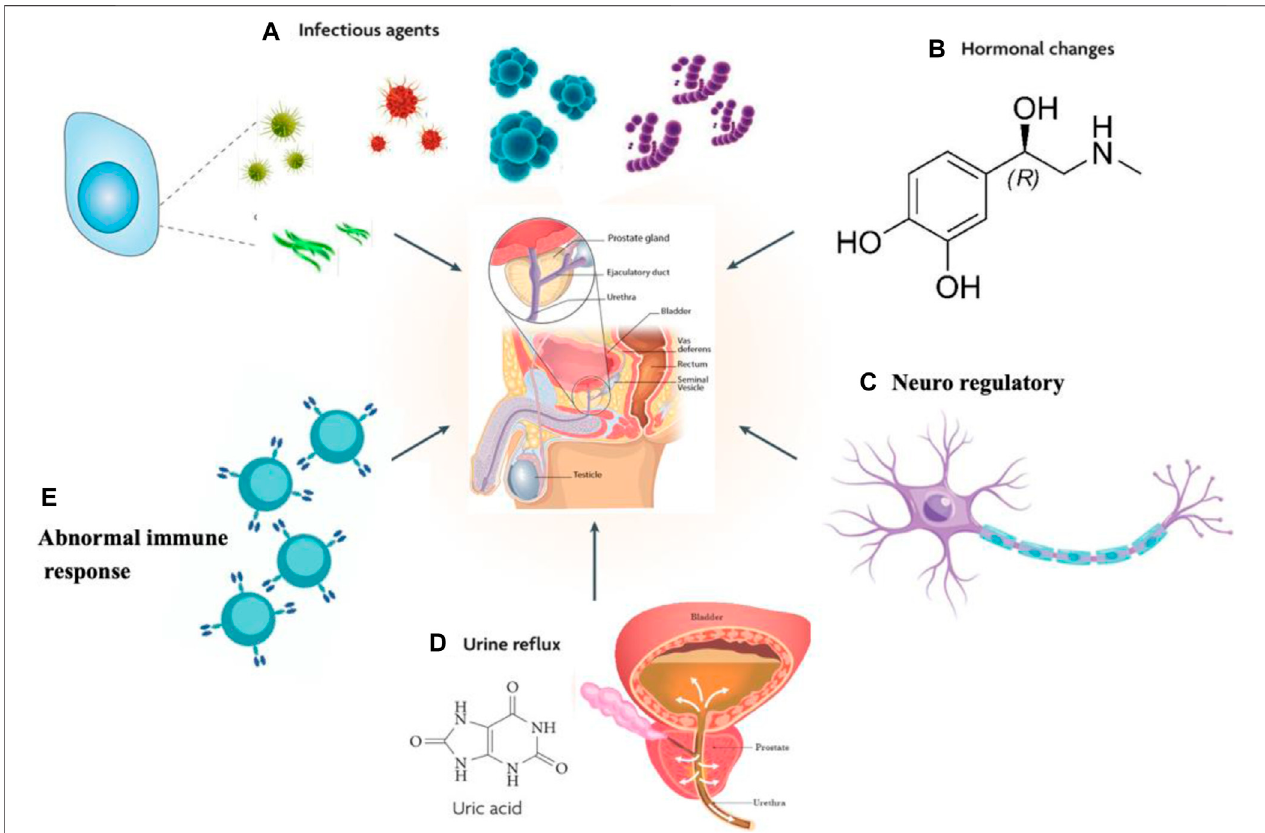
FIGURE 1 | Possible causes of prostate in fl ammation. ( A ) Pathogen infection. ( B ) Sex hormone imbalance. ( C ) Urination dysfunction. ( D ) Neuroregulatory mechanisms. ( E ) Abnormal immune response.